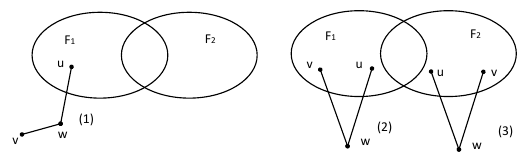
Figure 1. An illustration for Lemma